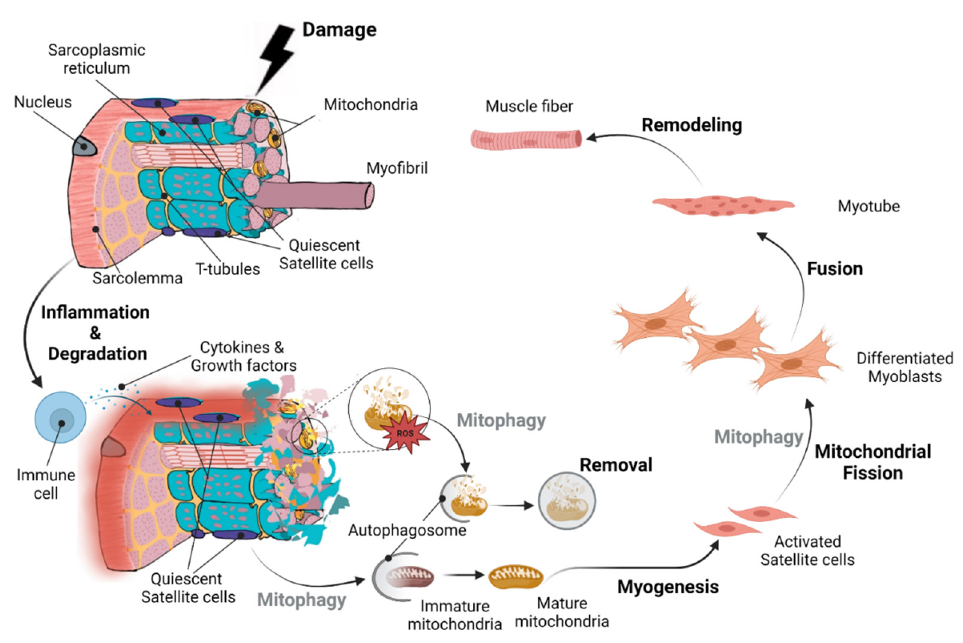
Figure 1. Overall sequence of events during skeletal muscle regeneration and remodeling fol- lowing damage. Extensive intracellular mitochondrial modification (i.e., mitochondrial turnover and clearance as well as mitochondrial network reformation) is required in parallel with satellite cell activation and differentiation to repair or generate new myofibers. Mitophagy plays a key role in the repair and/or formation of new muscle fibers through muscle regeneration and myogenesis. Under normal conditions, satellite cells, which are skeletal muscle precursor cells, remain in a dormant state (quiescent satellite cells) between the basal lamina and sarcolemma of muscle fibers. After muscle damage, these cells become active through the influence of cytokines and growth fac- tors released by immune cells. Quiescent satellite cells go through a process of mitochondrial net- work remodeling (from immature to mature mitochondria) via mitophagy to create activated satel- lite cells, also known as myoblasts. As myoblasts differentiate and mature, they require further met- abolic remodeling through mitochondrial fission and mitophagy. The differentiated myoblasts can then fuse directly with the damaged myofibers to restore their structure and function, or fuse with each other to form myotubes that eventually develop into skeletal muscle